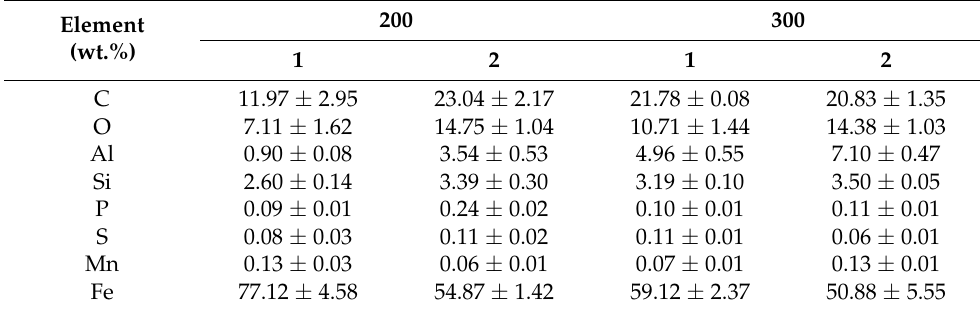
Table 8. EDS analysis of the tested